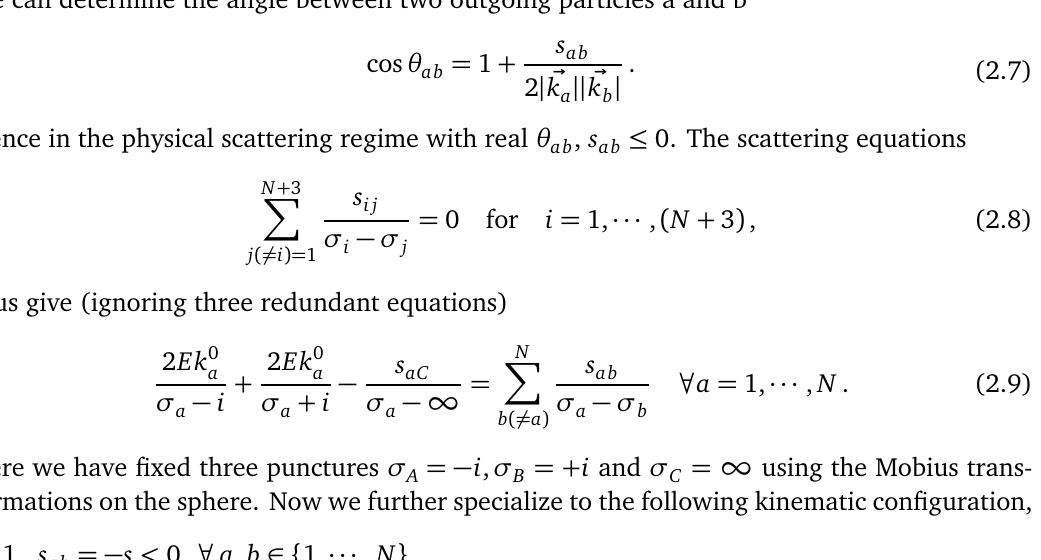
Figure 2.2: The scattering set-up: incoming particles A and B have high energies scal- ing with N which is the number of the scattered outgoing particles. These N particles all lie on the perpendicular plane to the same Mandelstam invariants s C will be incoming or outgoing depending on the kinematic variable ε k 0 / s , in the large N